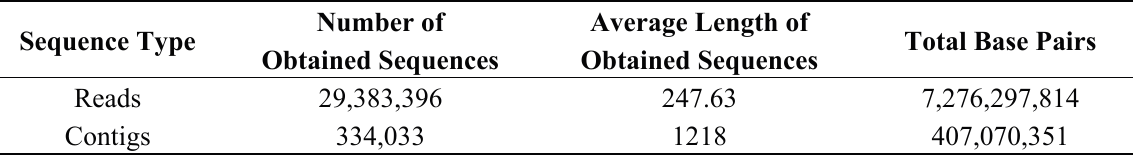
Table 1. Summary on next generation sequencing result of Dorcus